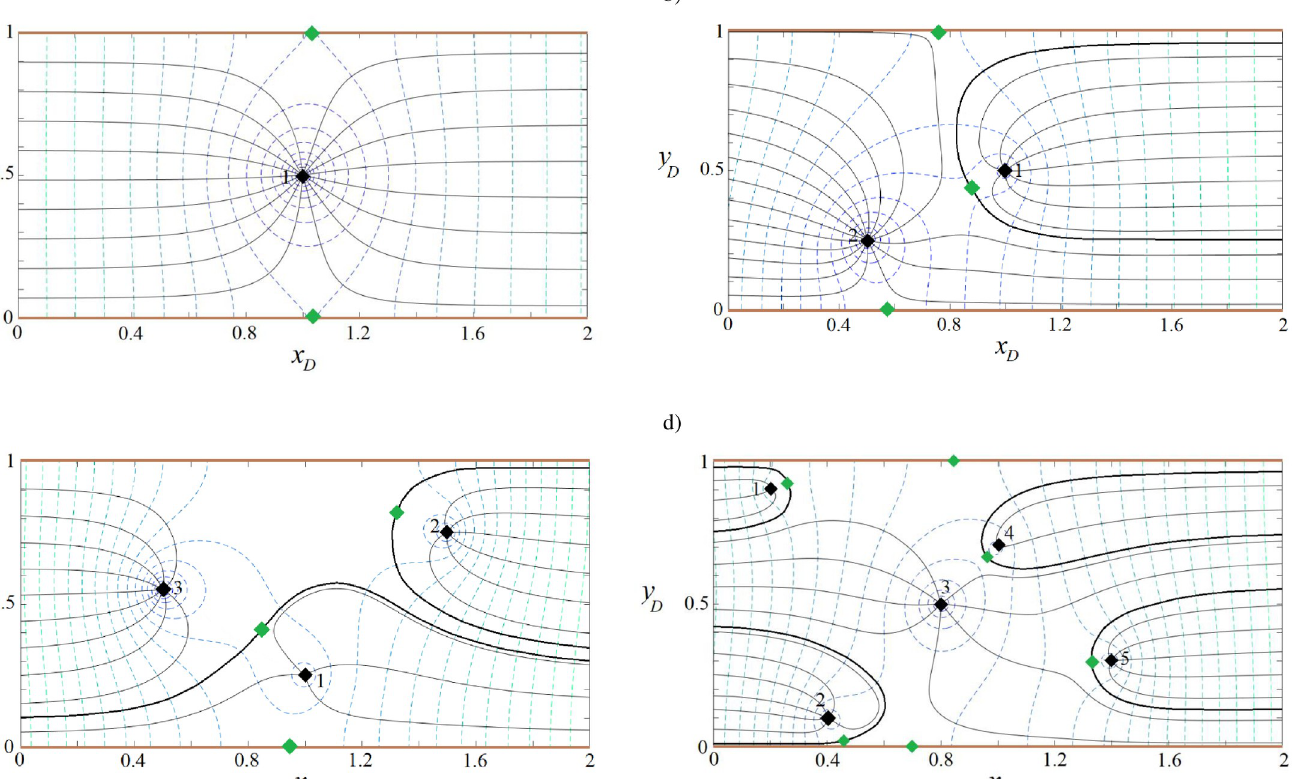
PLOS ONE | https://doi.org/10.1371/journal.pone.0229767 March 5,